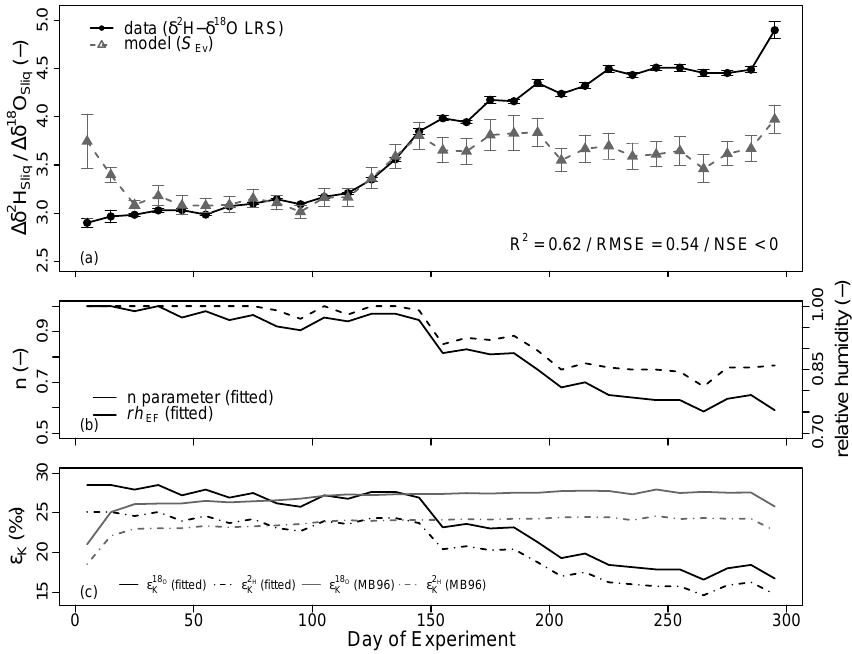
Figure 9. (a) Comparison between soil liquid water δ 18 O– δ 2 H linear regressions slopes (LRS, solid black line) calculated for time intervals of 10 consecutive days and simulated time series of evaporation line slope ( S Ev , dotted gray line) obtained from Eqs. (3)–(6) (Gat, 1971; Merlivat, 1978; Mathieu and Bariac, 1996). Black error bars give the standard errors of the estimated δ 18 O– δ 2 H LRS. Gray error bars are the standard errors associated with calculation of S Ev following Phillips and Gregg (2001). Coefficient of determination ( R 2 ), root mean square error (RMSE) and Nash and Sutcliffe efficiency (NSE) between model and data are reported. (b) Time series of n parameter (Eq. 6) and soil relative humidity at the evaporation front (RH EF ) that provided the best model-to-data fit. (c) ε 2 H n values (“fitted”) and calculated following Mathieu and Bariac (1996)